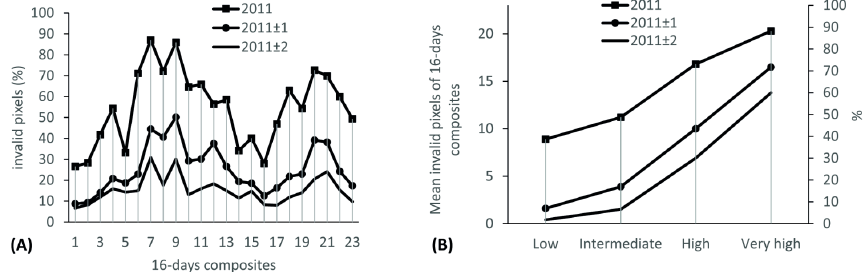
Figure 5. Reduction of invalid pixels by multi-year data integration for 2011, employing data ± 1 or ± 2 years. ( A ) Reduction of the percentage of invalid pixels over the course of the year; and ( B ) reduction of invalid pixels for each spatial category of invalid pixels (Figure 3B and Table 4).